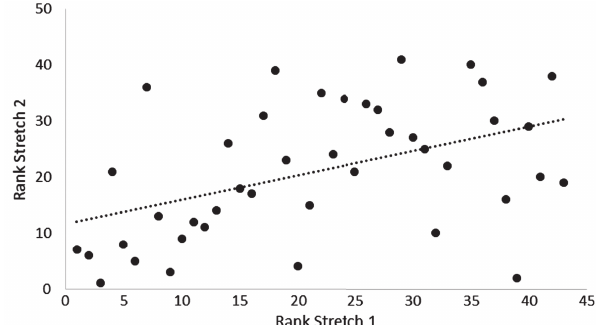
Fig. 5. Correlation between the rank order of individual migration speeds between stretch 1 (S1) and stretch 2 (S2). r 2 value = 0.214.